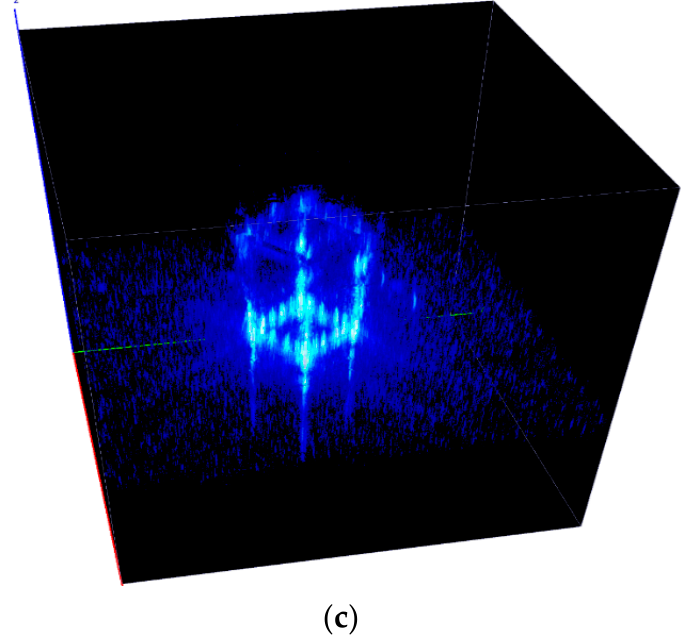
Figure 9. The 3D imaging experimental results of CSAS for steel cube target. ( a ) The reconstruction in the height direction at angle bin = 200; ( b ) the 2D slice imaging result at steel cube bottom; and ( c ) the 3D imaging result of the steel cube. It also contains the bottom image of lake.